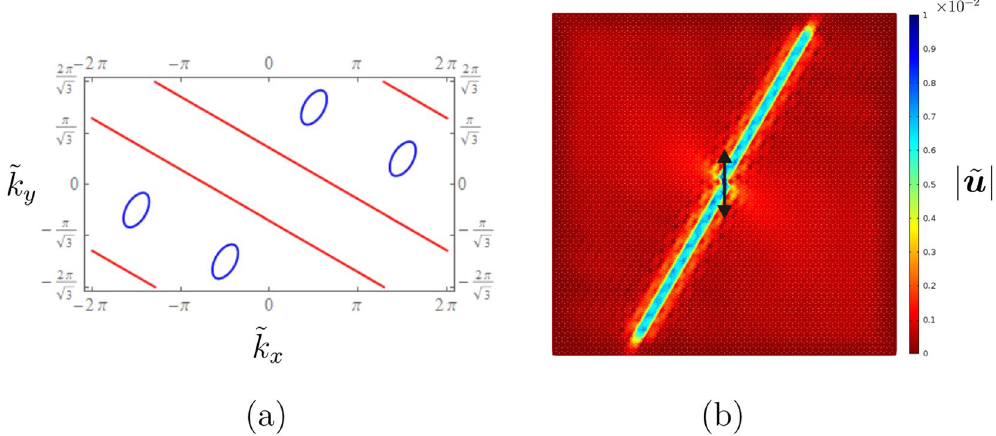
Figure 4. ( a ) Slowness contours and ( b ) amplitude field of the total normalised displacement, calculated at = = .   f f 0 94 GB in a gyro-system with equal and opposite spinner constants ( α α = . = − .   0 9, 0 9 1 2 ), under a vertical harmonic displacement of amplitude 0.01. The lattice in ( b ) is approximately a square of side length equal to 60 and it is surrounded by PML, the parameters of which have been tuned to maximise the reduction of reflected waves.